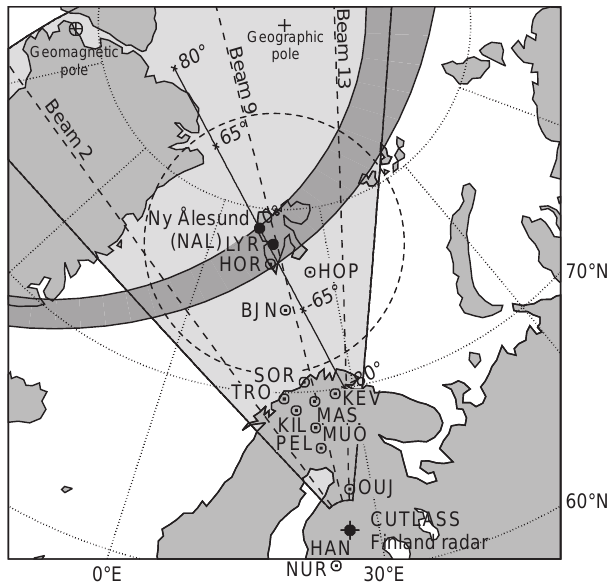
Fig. 1. The location of the field-of-view of the CUTLASS Finland radar; beams 2, 9, and 13 are indicated by dashed lines . The Ny A˚ lesund MSP meridian, projected to an altitude of 300 km, and the field-of-view of the Longyearbyen ASC are also indicated, as are the 15 IMAGE ground magnetometer stations employed in the study. The approximate location of the dayside auroral oval for quiet conditions is superimposed